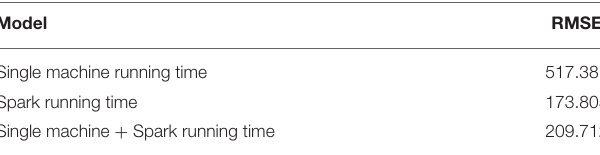
TABLE 3 | Comparison of root mean square error and model training time result comparison.